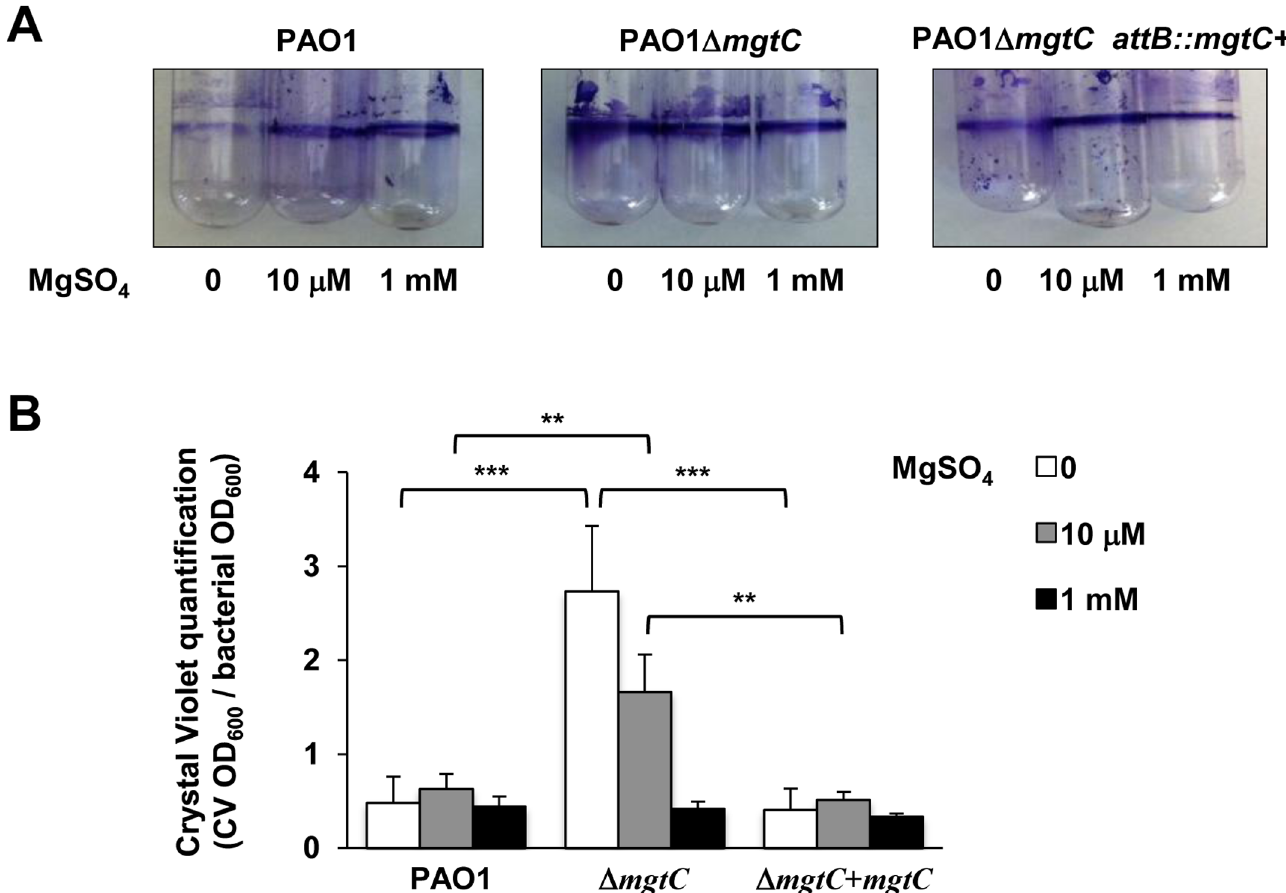
Fig 7. Quantification of bacterial adherence to glass tubes to infer the ability of strains to form biofilm. (A) Adherence assay with P . aeruginosa strains PAO1, PAO1 Δ mgtC , and PAO1 Δ mgtC attB :: mgtC + grown at 30°C for 24 hrs in minimal medium without MgSO 4 or with MgSO 4 (10 μ M and 1 mM). The biofilm quantification is visualized by crystal violet ring on the glass tube. (B) Crystal violet quantification (CV OD 600 ) is divided by the bacterial density (bacterial OD 600 ). Error bars correspond to standard errors (+ SE) from three independent experiments and the asterisks indicate P values (Student ’ s t test, ** P < 0.01, *** P < 0.001).